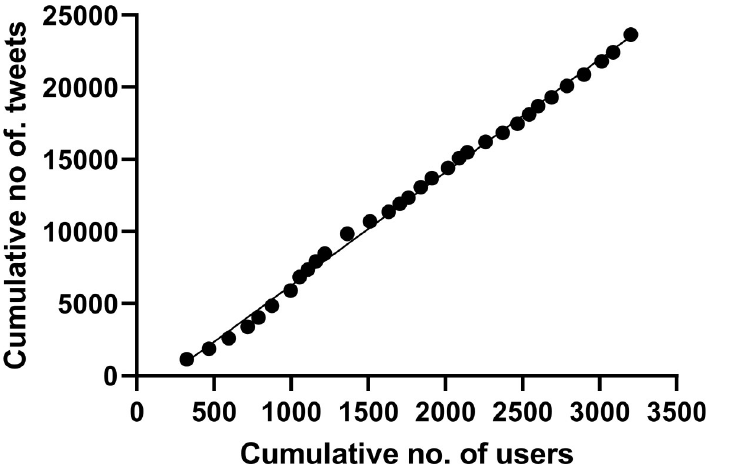
Fig 4. Cumulative numbers of tweets and users over time.